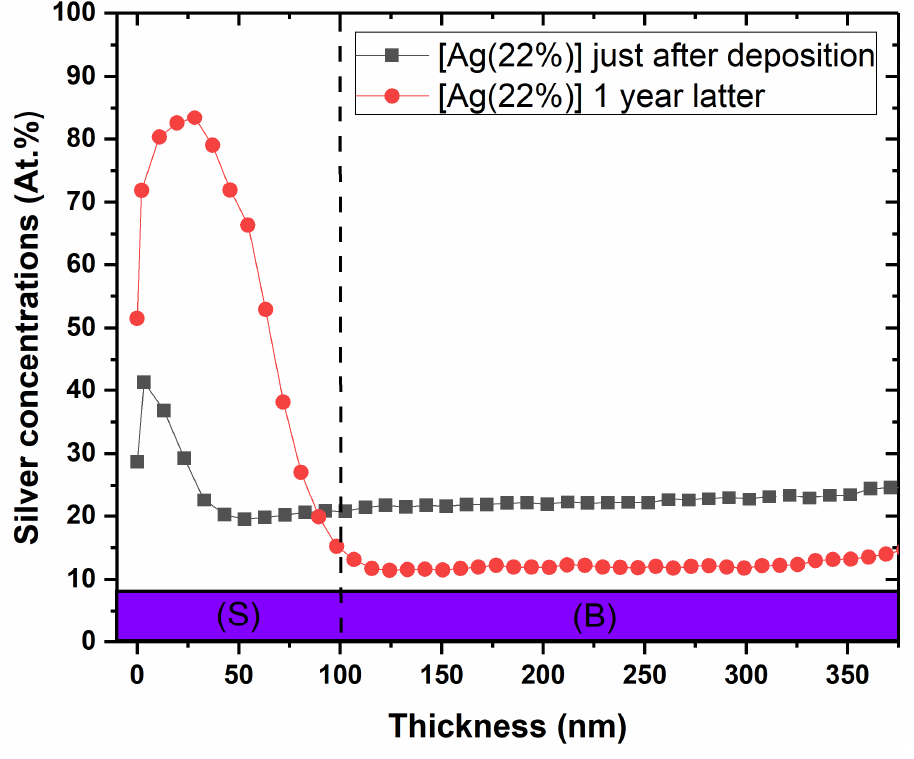
Figure 3. Ageing effect on silver depth concentration of the antimicrobial layer for [Ag22%)]. These depth chemical compositions were obtained by XPS analyses just after deposition ( ⬛ ) and one year later (●). (S) = surface ranging from 0 to 50 nm; (B) = bulk.